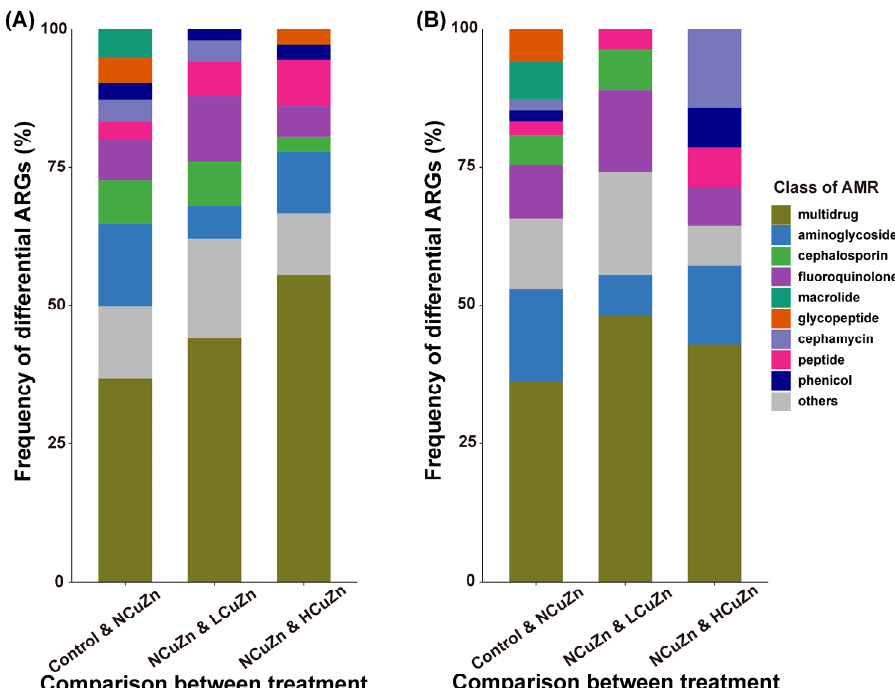
Figure 4. Differential ARG profiles between the experimental groups used in this study. ( A ) Fre ‐ quency of total differential ARGs between treatments (%), ( B ) frequency of differential ARGs (%) that increased in abundance because of manure application or heavy metal amendment. AMR, an ‐ timicrobial resistance.